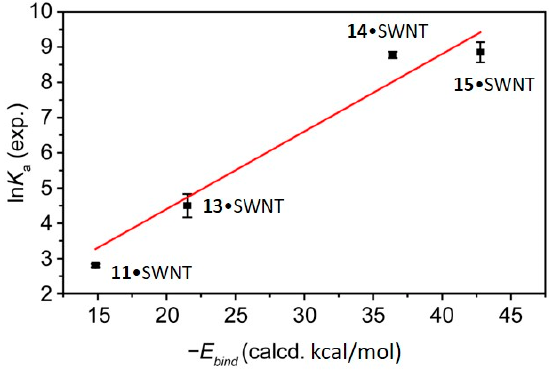
Figure 26. Plot of ln K a vs. − E bind , comparing the experimental and calculated data.